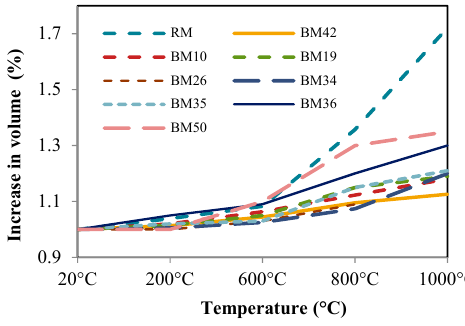
Figure 11. Relative volume as a function of high temperatures.